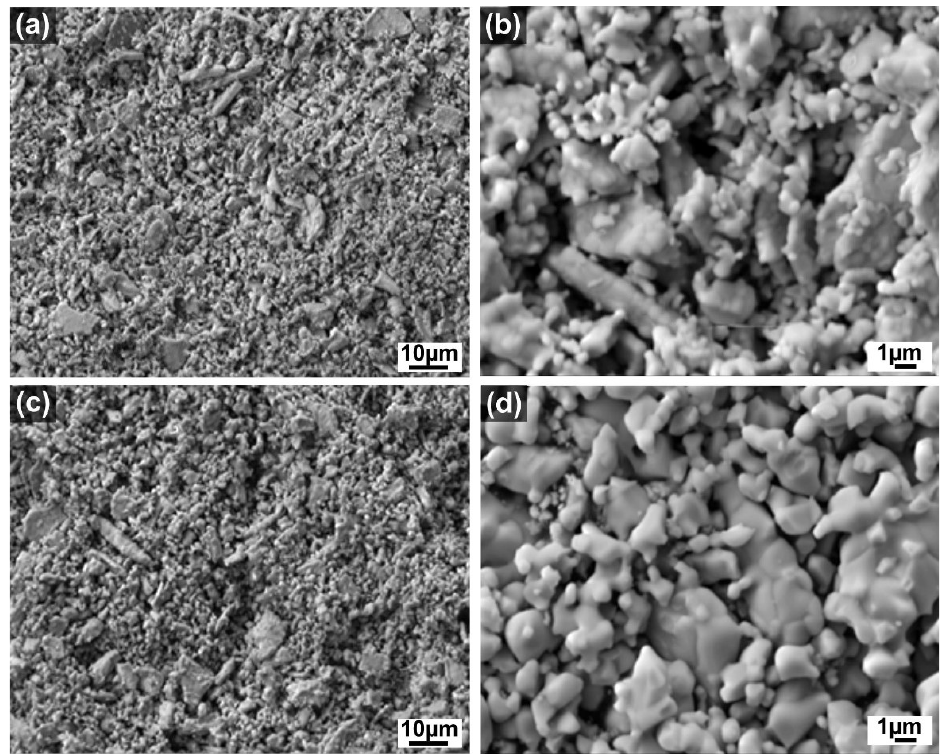
Figure 8. SEM images of the LC-SS powders calcined at different temperatures: ( a ) 1300 °C; ( b ) 1300 °C—higher magnification; ( c ) 1400 °C; ( d ) 1400 °C—higher magnification [41].